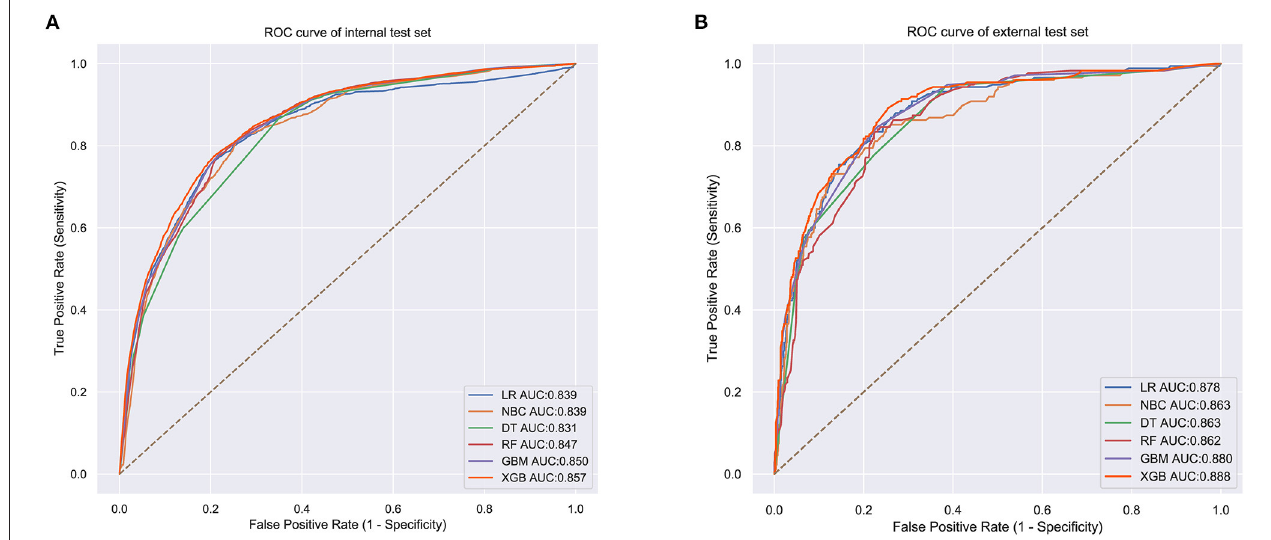
FIGURE 5 | (A) Internal test ROC curve of different machine learning models. (B) External test ROC curve of different machine learning